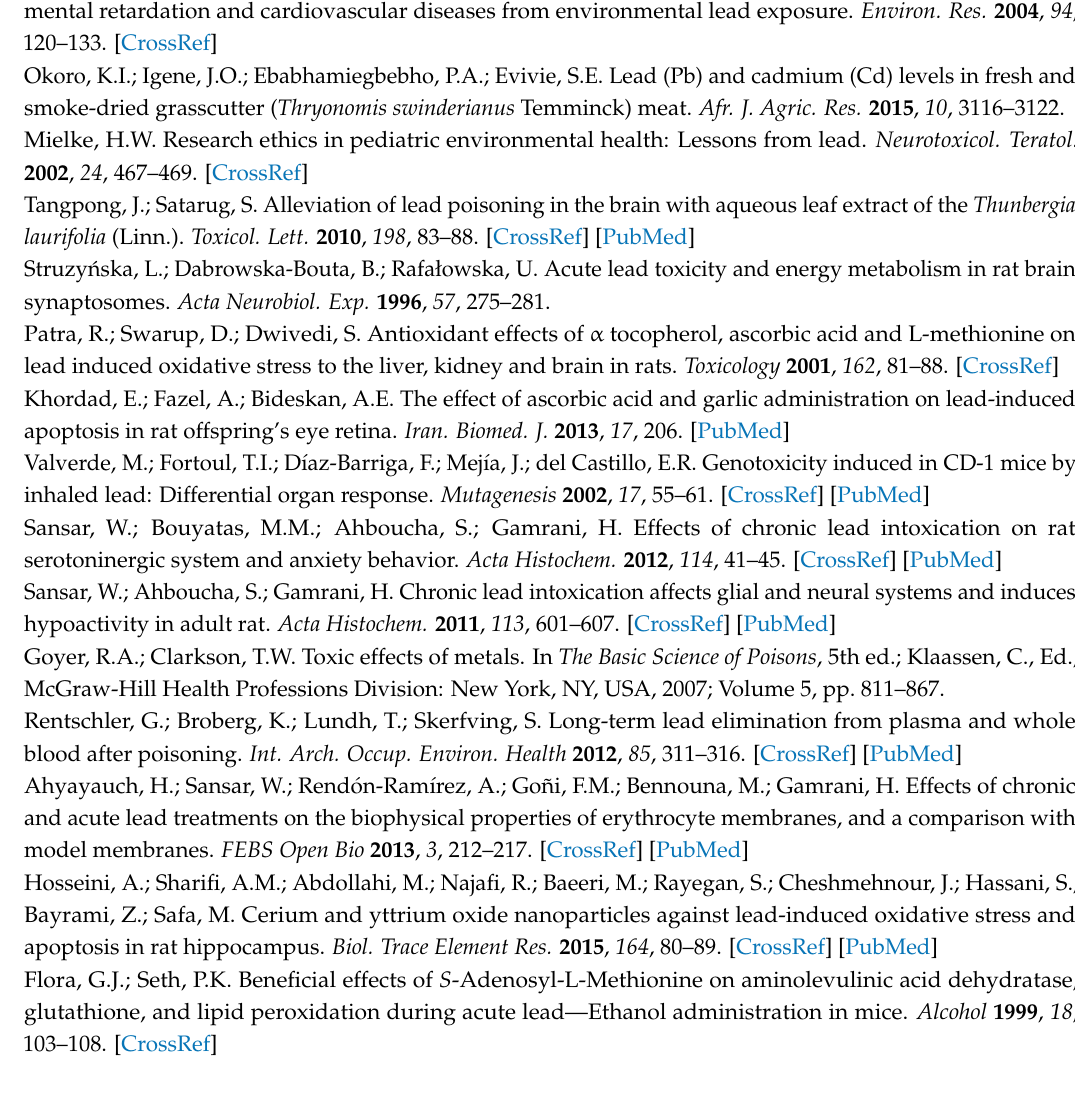
Figure S1: Kinetic models of the Pb binding by L. bulgaricus KLDS1.0207. (A) Pseudo first-order kinetic model of the Pb binding by L. bulgaricus KLDS1.0207 in the first 15 m. (B) Pseudo second-order kinetic model of the Pb binding by L. bulgaricus KLDS1.0207. Table S1: Adsorption constants derived from simulations with